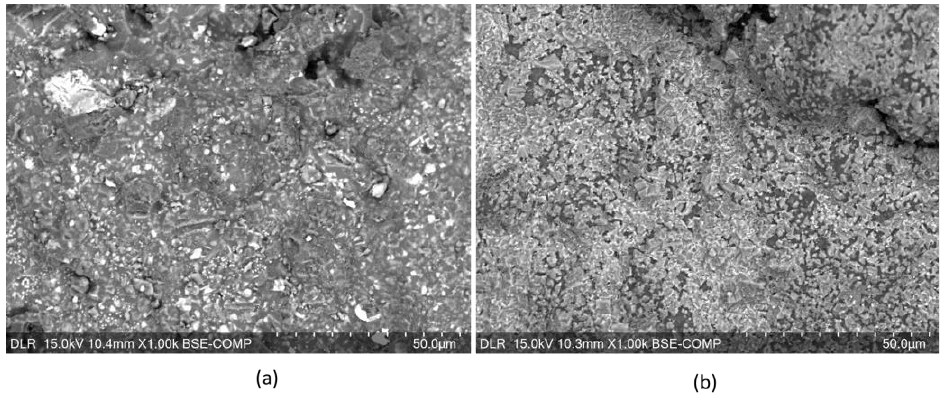
Figure 3. SEM micrographs revealing the surface of BL 1630 bauxite proppants ( a ) before and ( b ) after coating with black spinel-type pigment.